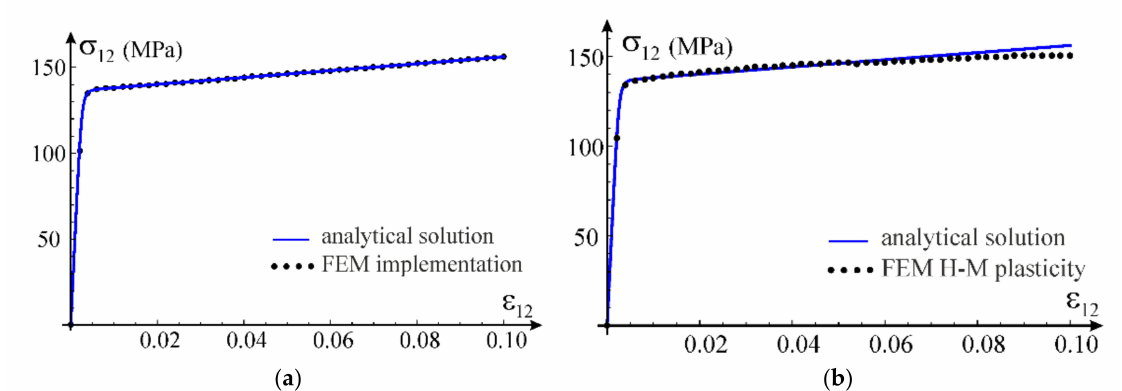
Figure 11. Comparison of the analytic nonlinear elastic solution for the pure distortion test with: ( a ) FEM solution according to our own implementation, ( b ) FEM solution based on standard elastic-plastic